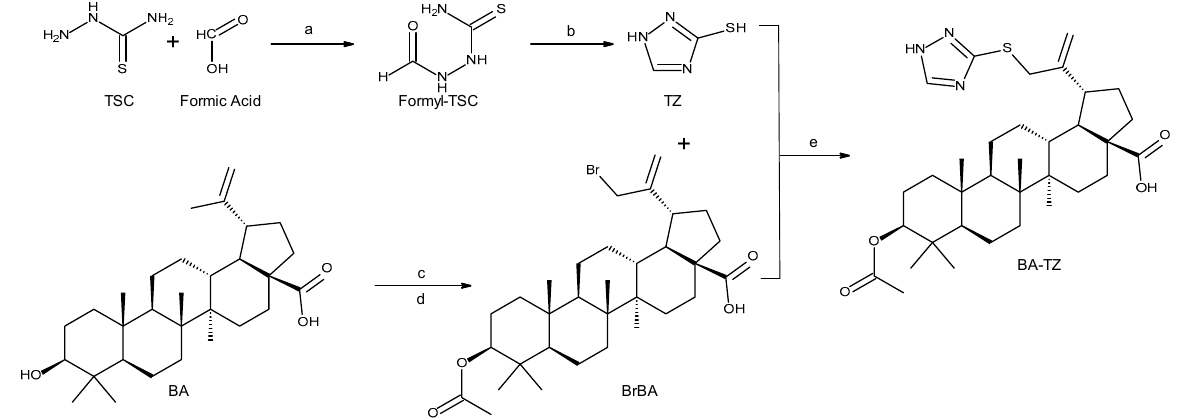
Figure 1. Synthesis pathways used to obtain 3 β - O -Acetyl-30-(1H-1,2,4-triazole-3-ylsulfanyl)-betulinic acid (BA-TZ); TSC = thiosemicarbazide, TZ = 1,2,4-triazole-3-thiol, BA = betulinic acid, BrBA = 3 β - O -Acetyl-30-bromo-betulinic acid; reaction conditions: a. reflux, 30 min; b. H 2 O, NaOH, reflux, 1h; c. acetic anhydride, pyridine, DMAP, r.t, 12h; d. NBS, CCl 4 , r.t, 48h; e. DMF, K 2 CO 3 , r.t, 72h. 2.2. The Effect of BA-TZ on the Viability of Normal and Malignant Melanoma Cell Lines BA-TZ cytotoxic activity on HaCaT and RPMI-7951 cell lines was analysed using the MTT assay (3-(4,5-dimethylthiazol-2-yl)-2,5-diphenyltetrazolium bromide) after a 24 h treatment period with various concentrations (0.08, 0.4, 2, 10 and 50 μ M). As shown in Figure 2, exposure of normal HaCaT cell lines to BA-TZ in concentrations up to 10 μ M did not significantly impact cell viability, whereas the positive control 5-fluorouracil (5-FU) at 10 μ M decreased cell viability at 59.66% vs. control. Similar results were obtained when BA and TZ alone were tested at the same concentrations on the HaCaT cell line (Figure 2). However, at the highest concentration (50 μΜ ), all tested compounds (BA, TZ and BA- TZ) significantly decreased cell viability vs. control (67.3%, 87.5% and 63.2%).